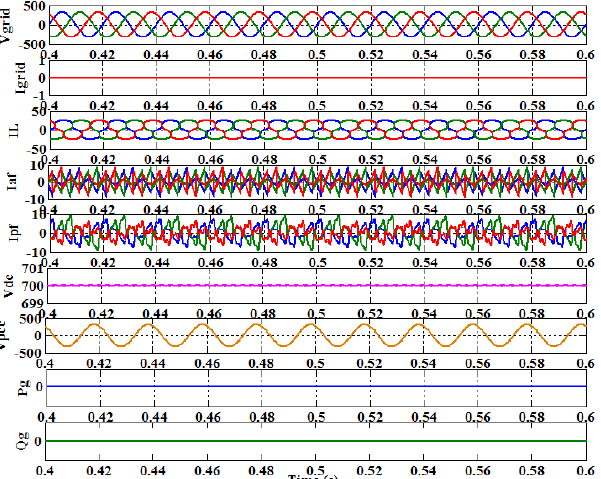
Figure 9. Grid voltage and current, Load current, Injected active filter current, Injected passive filter current, DC link voltage, PCC voltage, and Active and Reactive power drawn from the grid by the load connected at PCC for inductive load in islanded mode.